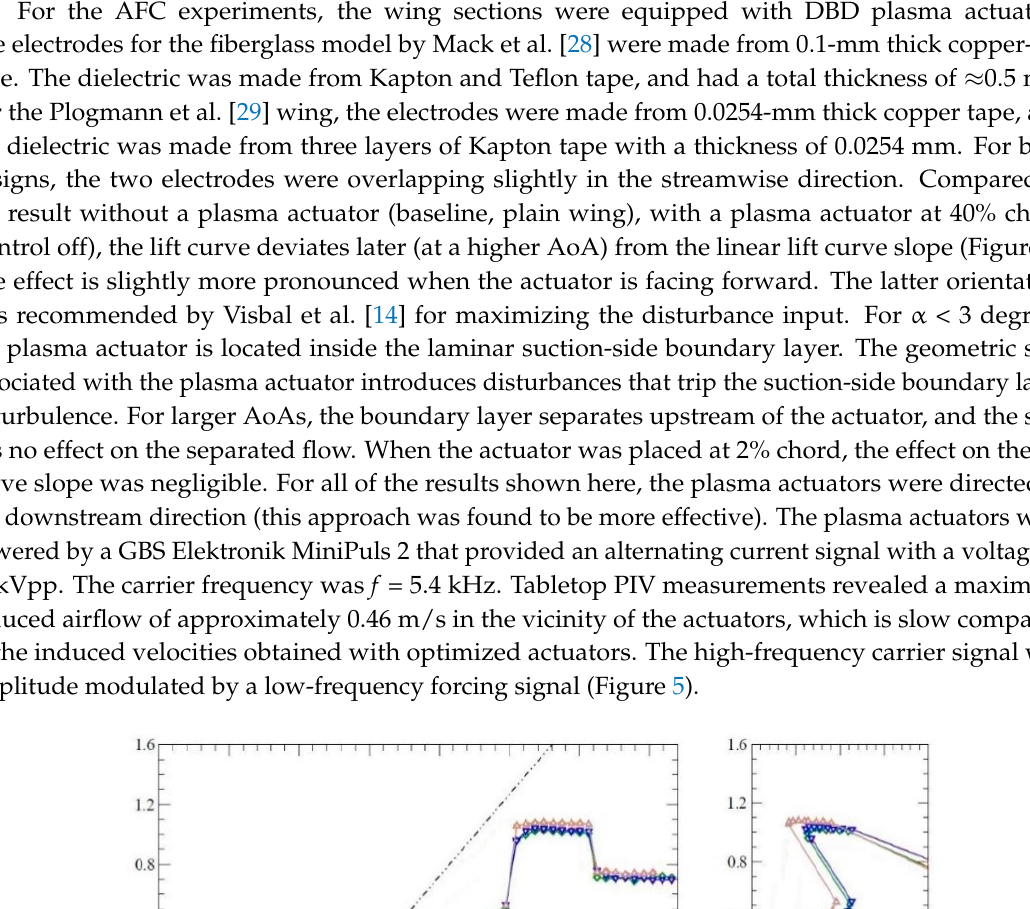
Figure 5. Harmonic amplitude modulation of carrier signal.